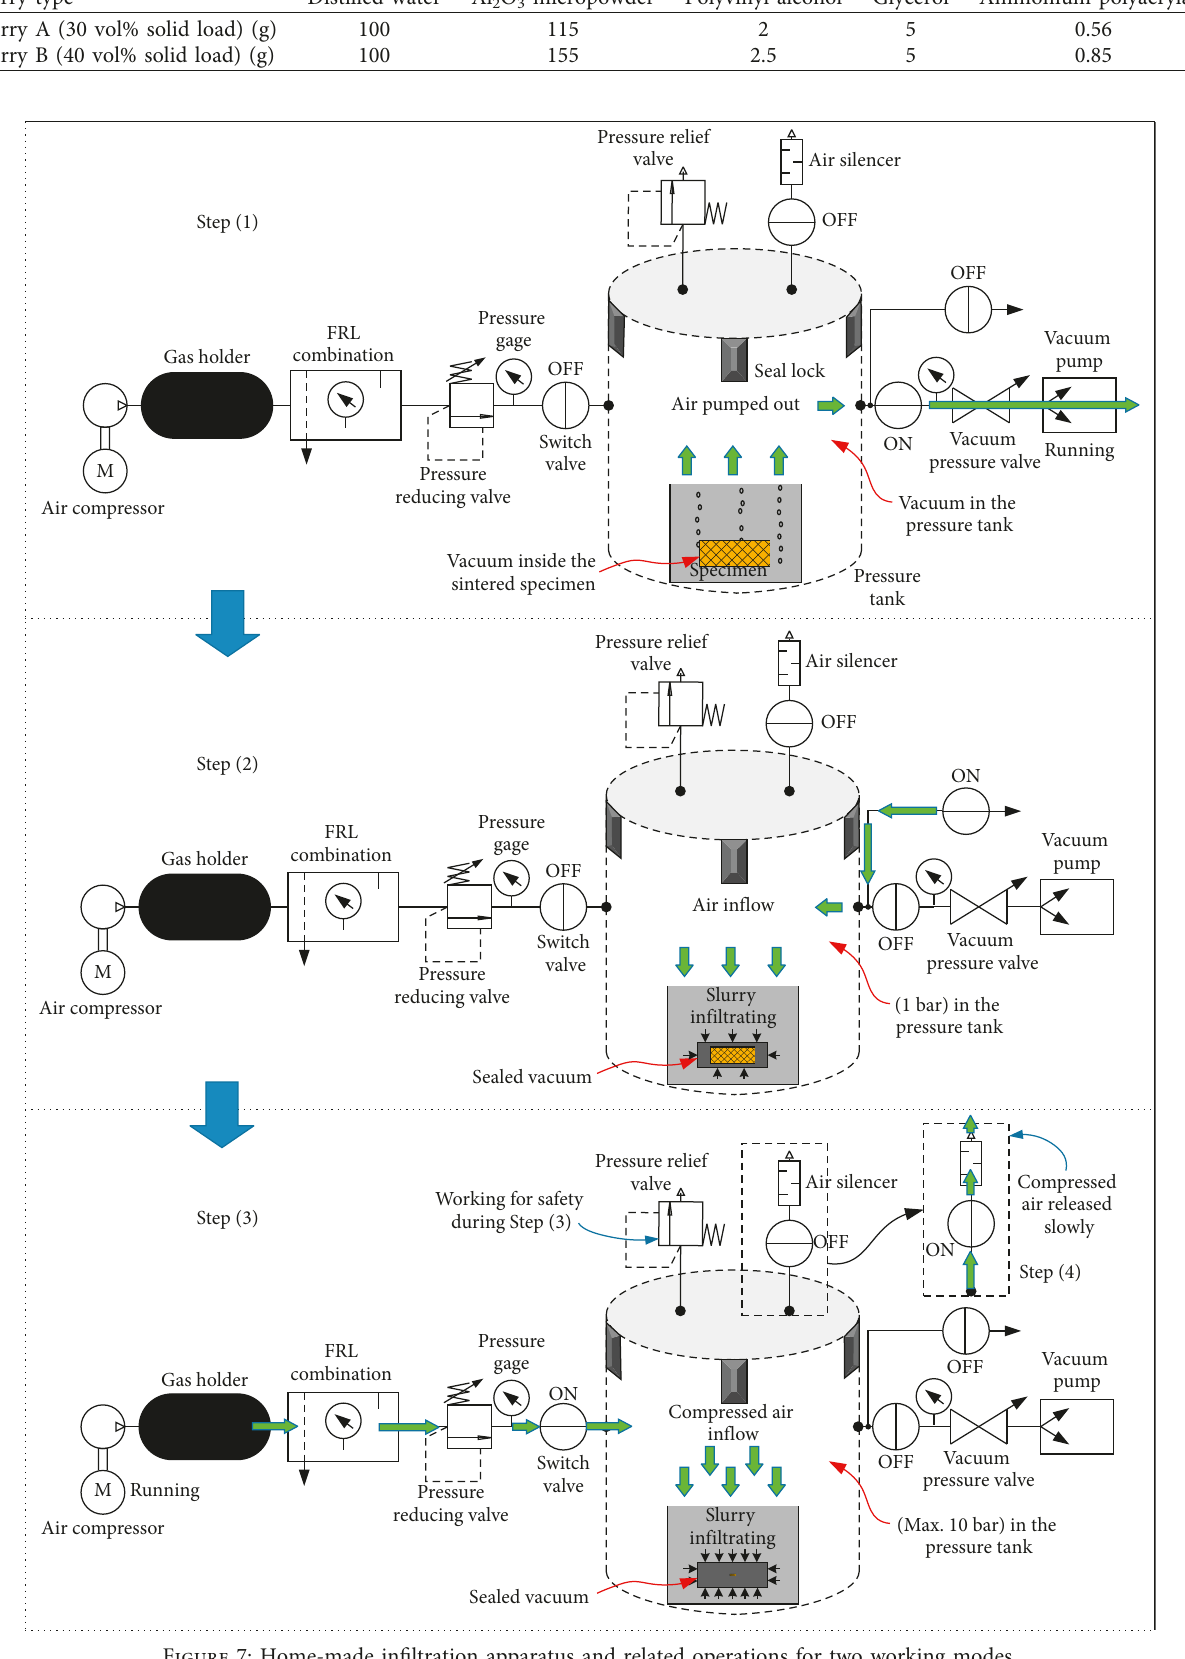
2 O 3 solid loads.